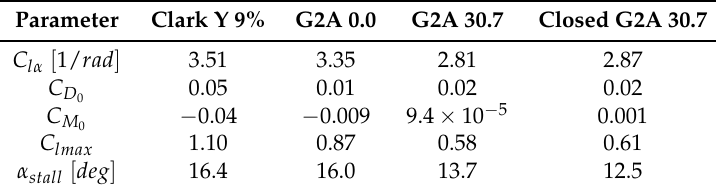
Table 2. Experimental main aerodynamic parameters.